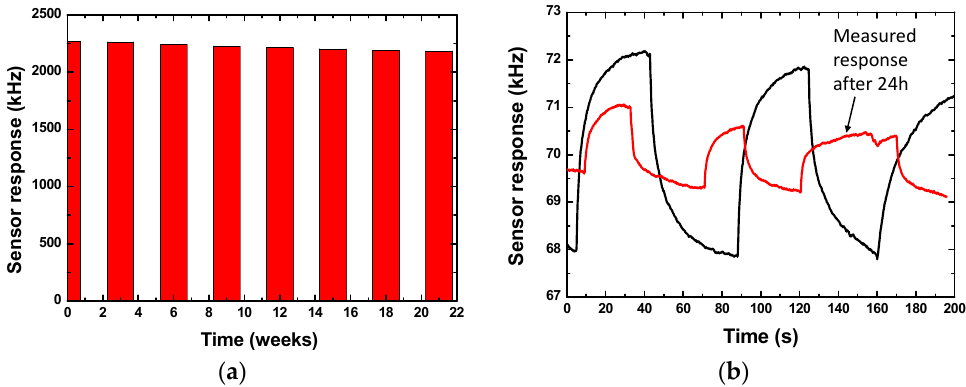
Figure 9. The measurement of the long-term stability of the 40 nm Pd-Ni alloy thin-film coated device ( a ), and the 40 nm Pd thin-film coated device ( b ).